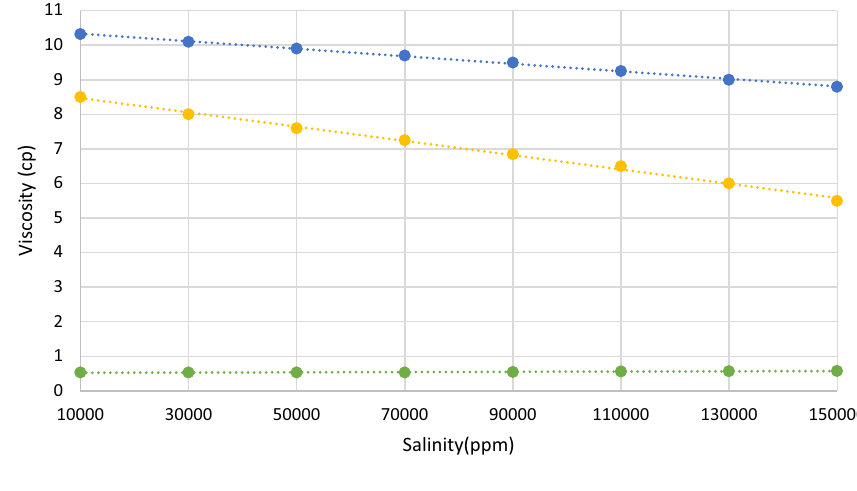
Fig. 7 Effect of the salinity on solution viscosity in high temperature condition